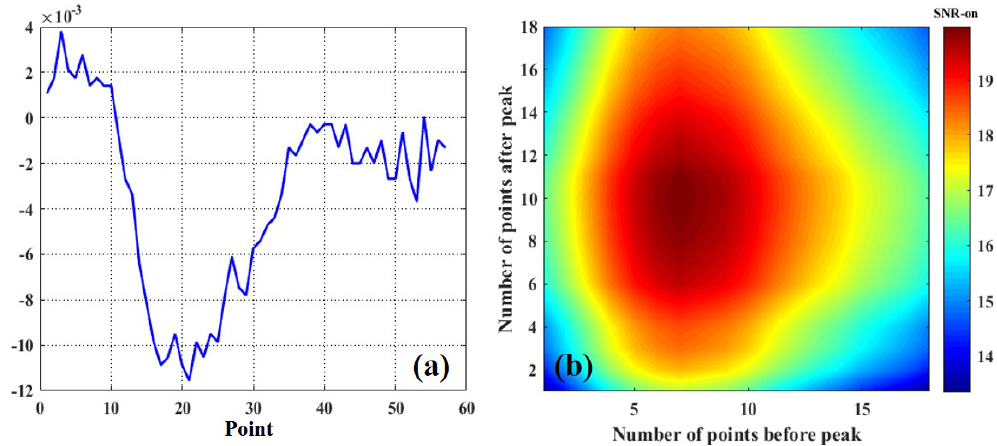
Figure 9. (a) Online wavelength echo pulse signal in ocean area. (b) The change of the SNR of the echo pulse signal in the ocean area with the number of selected pulse